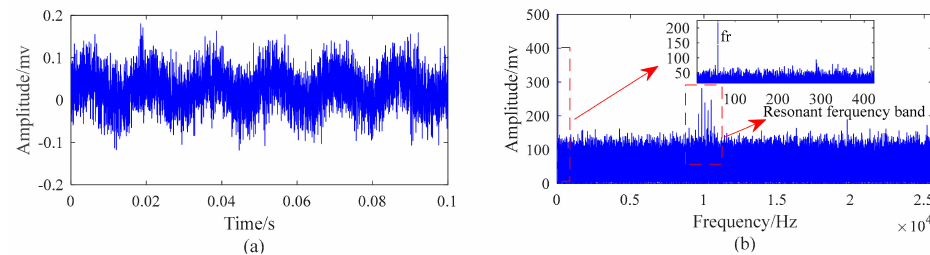
Figure 3. The waveforms and spectrum of the simulation signal: ( a ) waveforms; ( b ) spectrum.